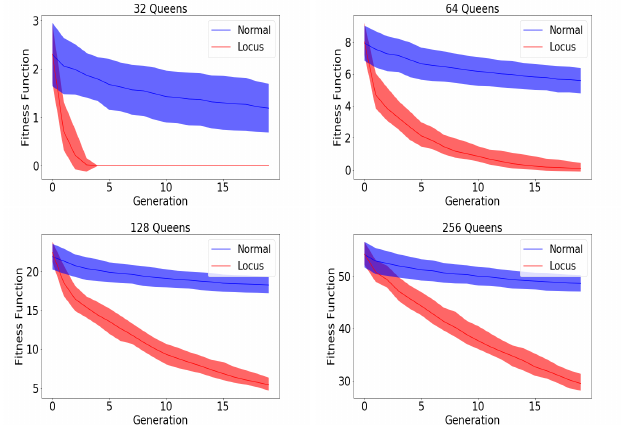
Figure 5. It depicts a comparison between Locus mutation and traditional mutation with different sets of parameters. The figures depict N-queens problem with 32, 64, 128 and 256 queens where the results have been averaged out with two different generation size [200, 400], [400, 600], [600, 800] and [800, 1000] respectively. We only selected the best solution out of these five different values of mutation rate [0.01, 0.1, 0.6, 0.3, 0.9]. The center of the curve is the expected value while the range visualize the standard deviation. All the experiments have been repeated 50 times and then averaged out. We can notice that the number of hitting queens is escalating when we increase the number of queens. Table 1. N-Queens optimal solution, minimum number of hitting queens, after 20 generations. Two different population size PopSize , 200 and 400, have been investigated with 50 different repeti- tions. All the runs have been averaged